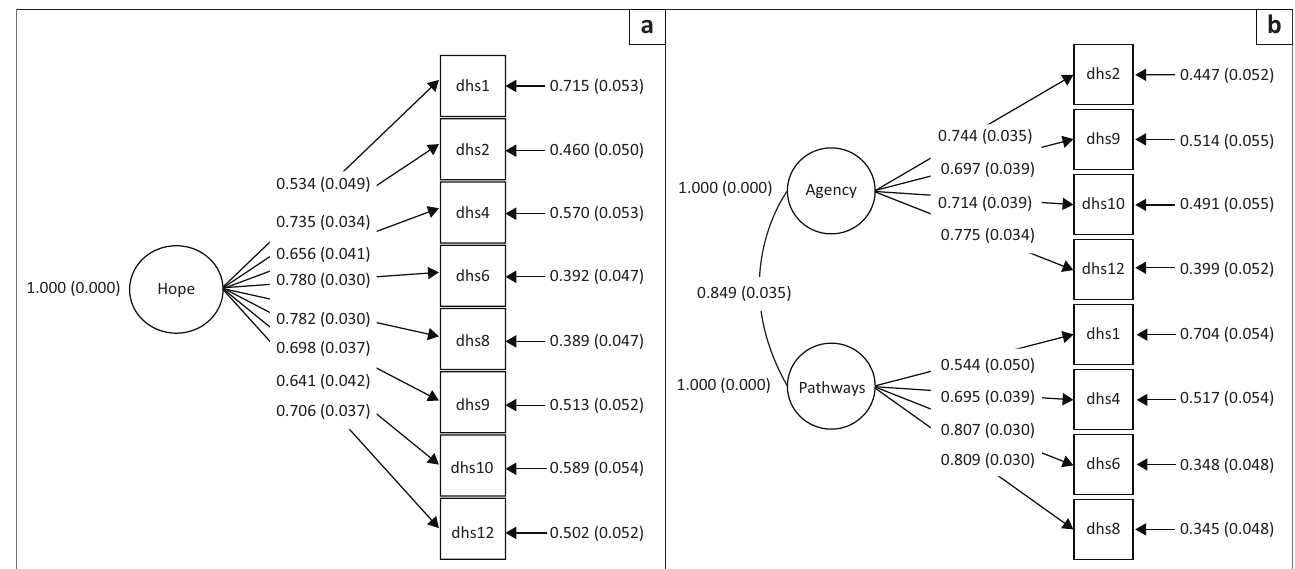
FIGURE 3: The confirmatory factor analysis (CFA) models for sample 2 ( n = 251). (a) The unidimensional solution, and, (b) the two-factor solution. TABLE 4 : Descriptive statistics: Sample 2 ( n = 251), based on confirmatory factor analysis two-factor model. Variable Mean Variance Minimum